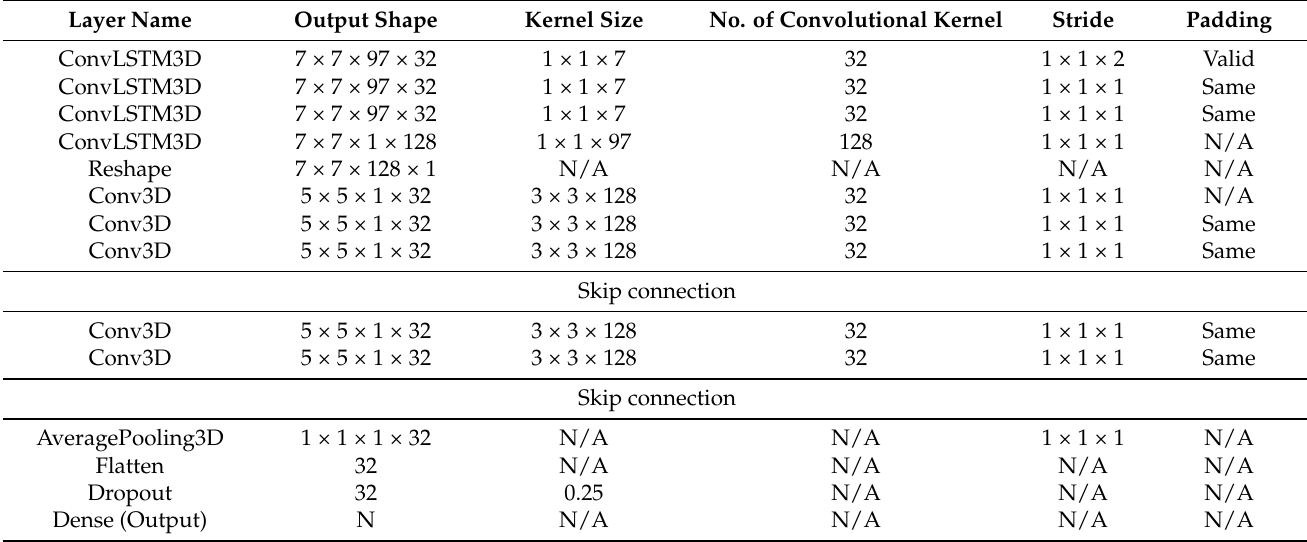
Table 5. Network topology of the proposed SSCRN model.